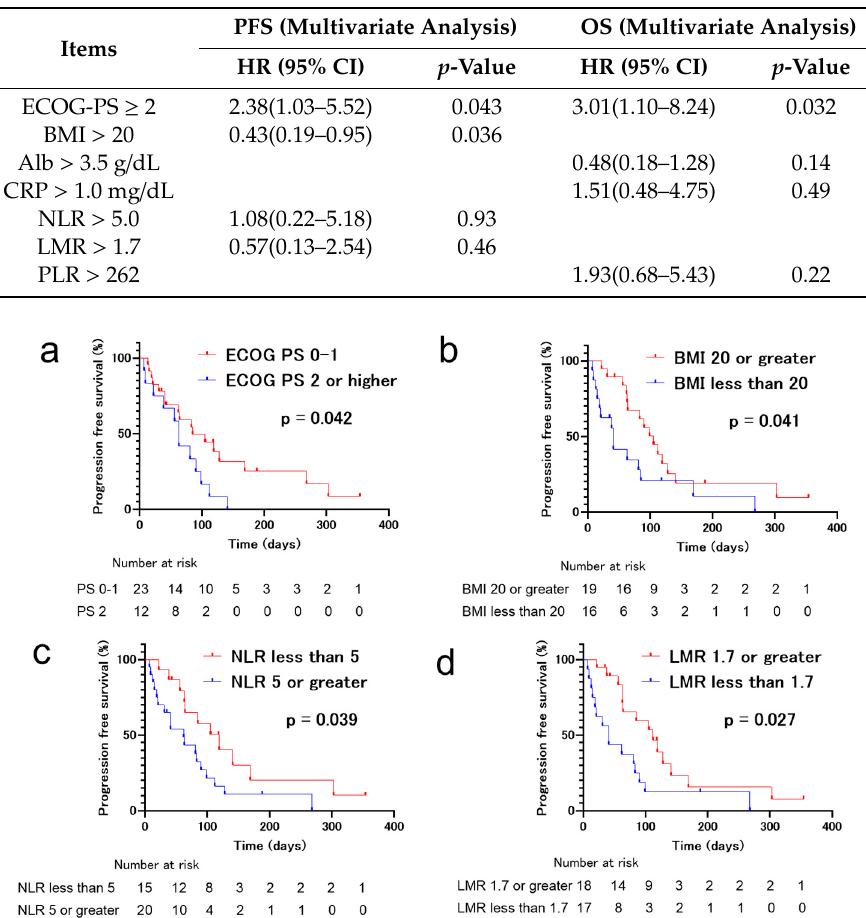
Table 3. Cox proportional hazards and logistic regression models for progression-free survival (PFS) and overall survival (OS).